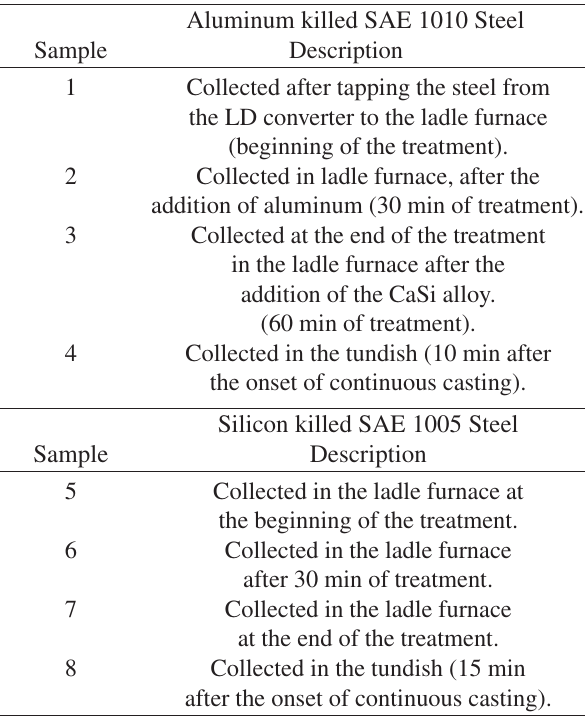
Table 1. Sampling sequence of SAE 1010 and 1005 steels during the phases of the